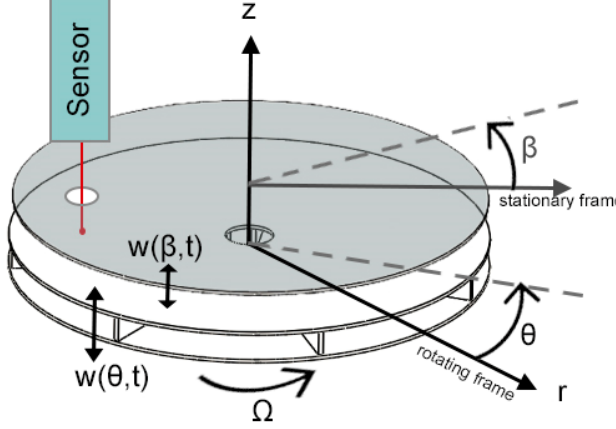
Figure 7. Rotating and stationary frame.